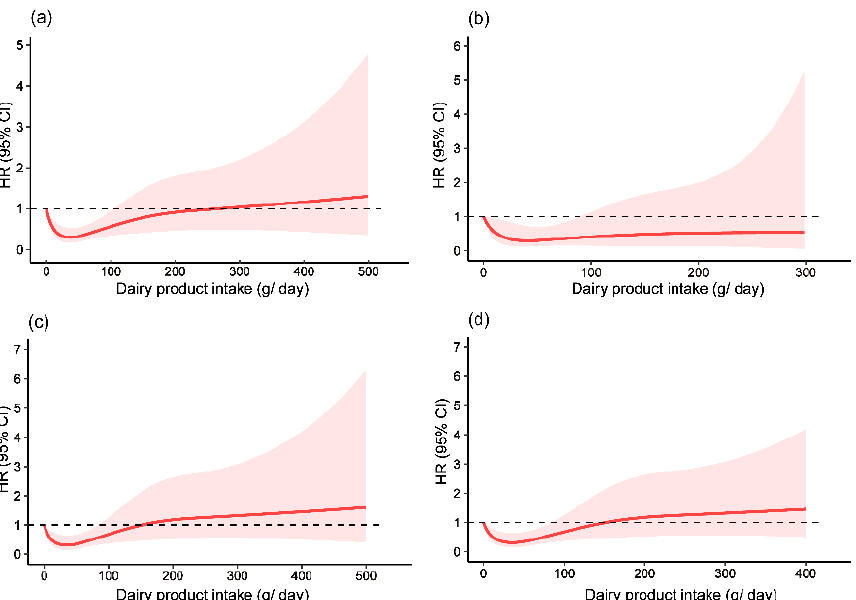
Figure 2. Restricted cubic spine plots to evaluate relationships between dairy product intake and fracture among ( a ) overall participants; ( b ) men; ( c ) women; and ( d ) women aged ≥ 45 years. HR and 95% CI were adjusted for age, sex, education level, region of residence, individual annual income, smoking history, drinking history, physical activity, BMI, chronic disease history, and intakes of total energy and total calcium.